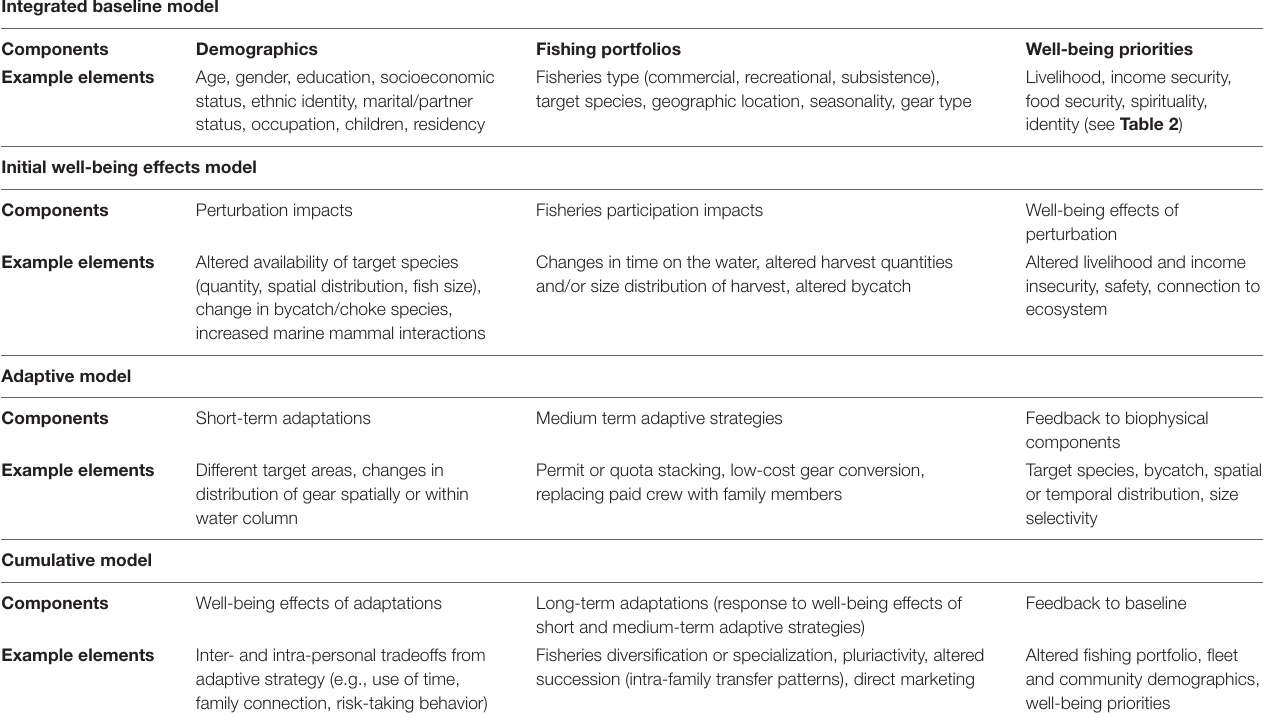
TABLE 3 | Components and example elements of data needed for the human dimensions conceptual